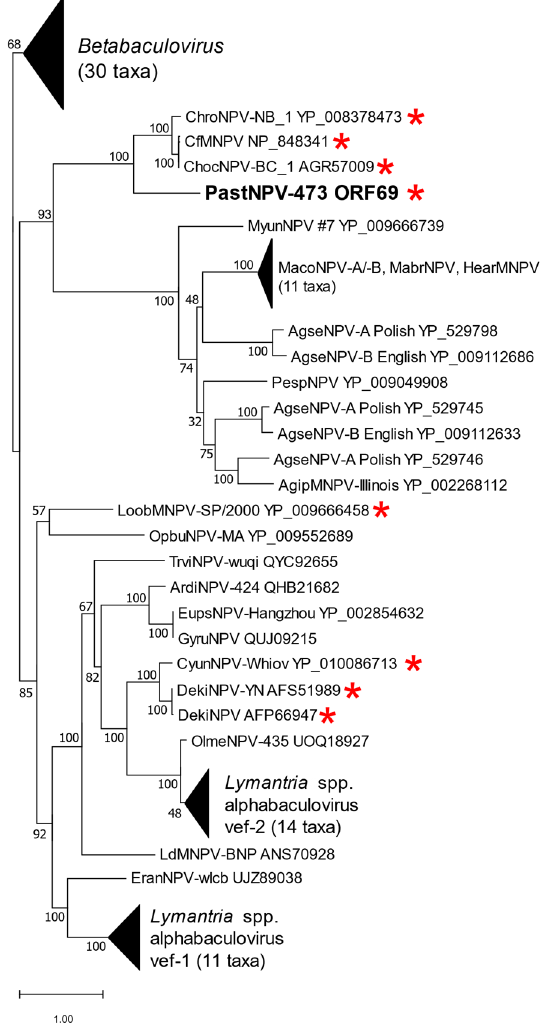
Figure 5. Phylogeny of PastNPV-473 ORF69 and other enhancin (viral enhancing factor; vef) amino acid sequences from baculoviruses. A maximum likelihood phylogeny inferred from an alignment of enhancin homologs is shown, with betabaculovirus enhancin sequences as an outgroup and bootstrap support for the branches. Abbreviations and Genbank accession numbers of viruses in the tree are provided; the viruses used in this analysis are listed in Table S1. PastNPV-473 ORF69 is indicated in bold type, and group I alphabaculovirus sequences are indicated with red asterisks. Branches for enhancins from betabaculoviruses and from alphabaculoviruses of Lymantria spp. and Mamestra spp. hosts are collapsed.